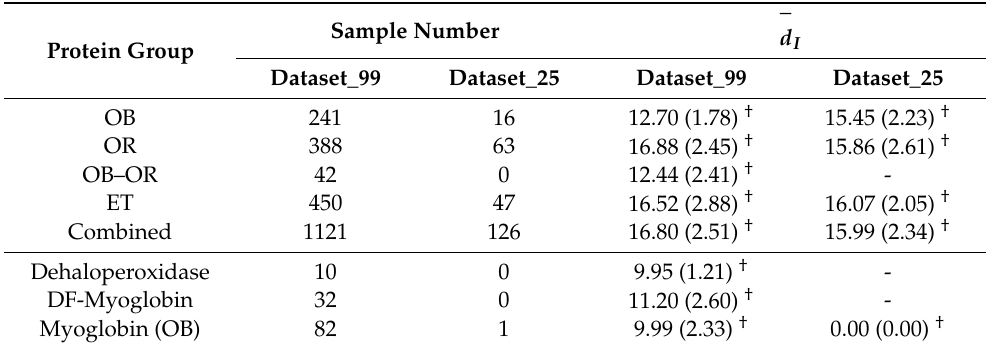
Table 6. Protein groups, sample numbers, and d I . The shaded row represents the protein group combined OB, OR, OB–OR, and